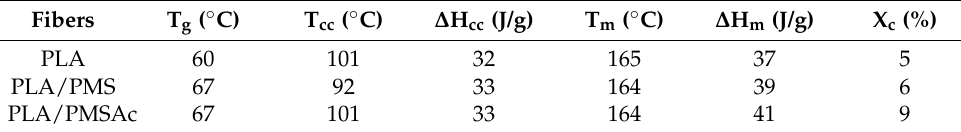
Figure 6. DSC curves of the different electrospun fibers. Table 1. Thermal parameters obtained from the different